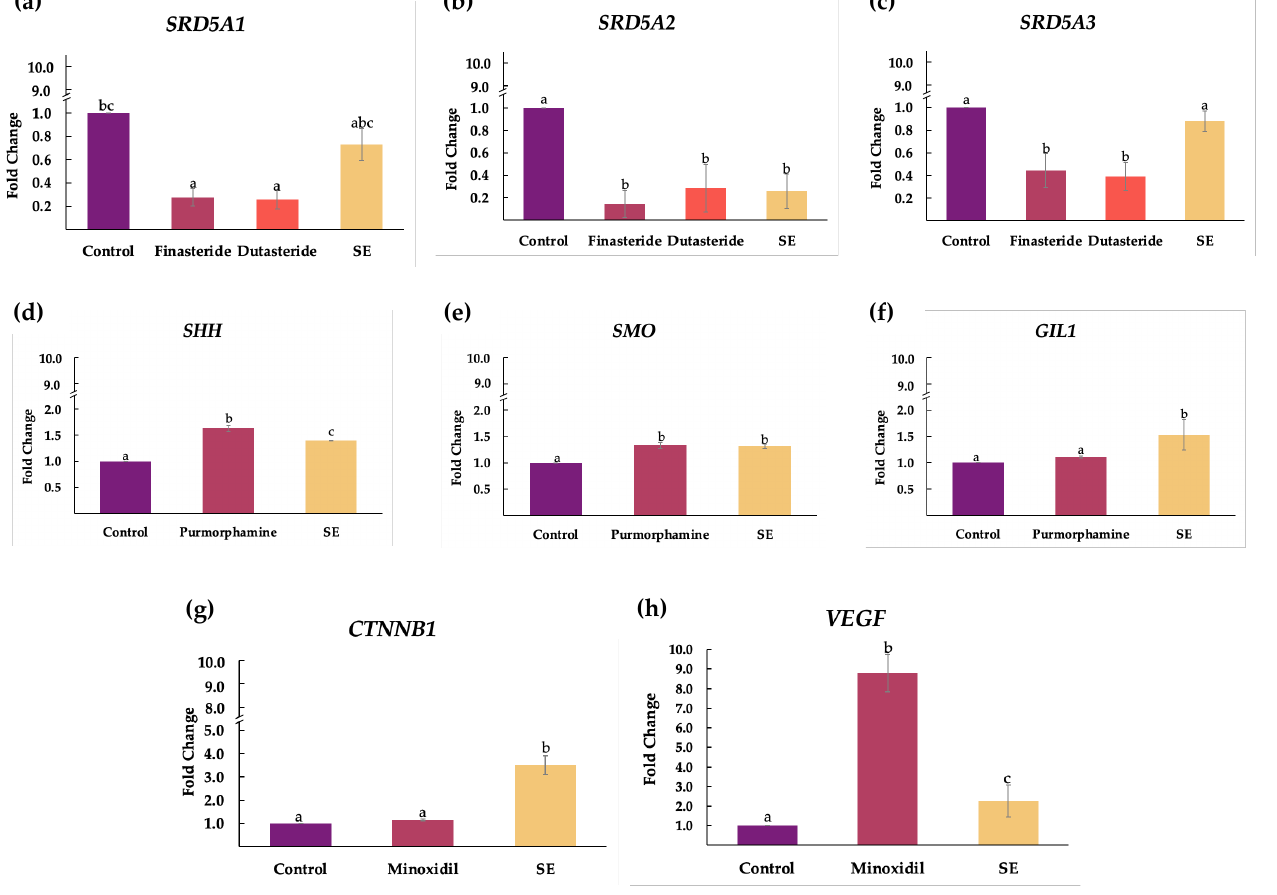
Figure 4. Effect of shallot extract (SE, 0.1 mg/mL) on expressions of genes associated with androge- netic alopecia: ( a ) SRD5A1 ; ( b ) SRD5A2 ; ( c ) SRD5A3 ; ( d ) SHH ; ( e ) SMO ; ( f ) GIL1 ; ( g ) CTNNB1 ; ( h ) VEGF . DU-145 human prostate cancer cells (DU-145) were used to observe the expressions of genes in the androgen pathway ( SRD5A genes), whereas human hair follicle dermal papilla cells (hHFDPC) were used to study the remaining pathways. Different letters (a, b, and c) indicate statis- tical significance ( p < 0.05) in comparison to control, finasteride (0.1 mg/mL), dutasteride (0.1 mg/mL), purmorphamine (0.1 mg/mL), and minoxidil (0.1 mg/mL).